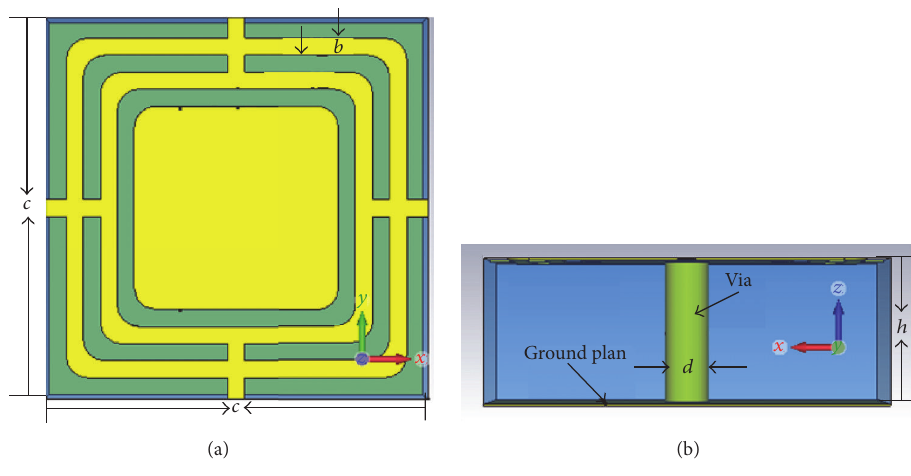
Figure 1: The EBG unit cell schematic. (a) Top view. (b) Side view.